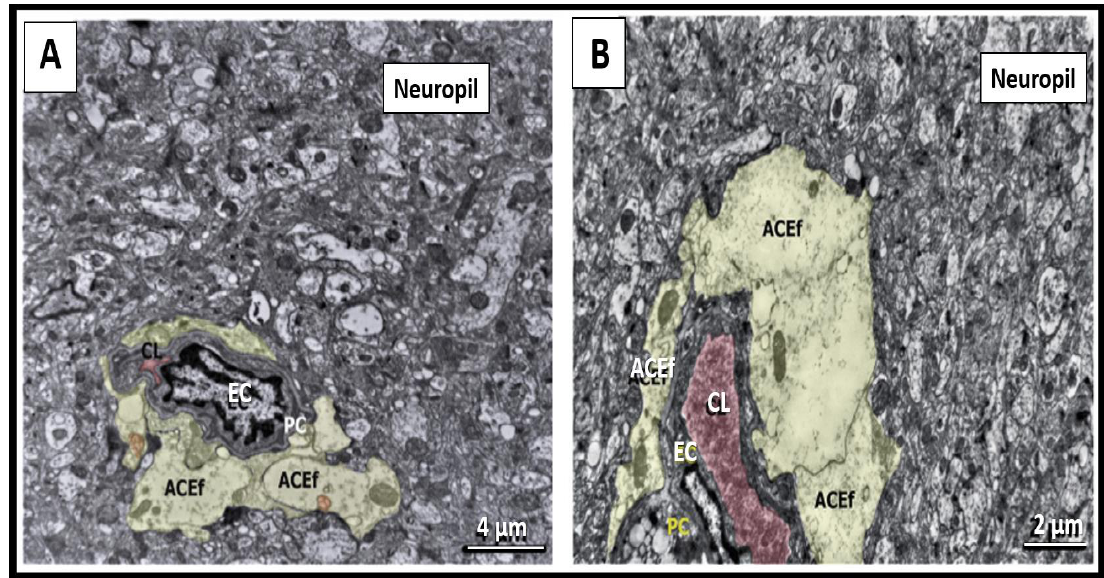
Figure 2. Ultrastructure of the cortex in acute hepatic encephalopathy. Panel ( A ) depicts the deformation and subtotal collapse of capillary lumen (pseudo-colored red) as compared to control models in Figure 1A. Note the asymmetric profound edema of astroglial capillary endfeet (pseudo-colored yellow) with several multivesicular bodies (MVBs pseudo-colored orange) from the cortex of a survived AILF-A rat 24 h after the procedure. Panel ( B ) depicts the flattened deformation of capillary lumen (pseudo-colored red) filled by condensed blood plasma. Note the asymmetric profound edema of the astroglial capillary endfeet (pseudo-colored yellow) from the cortex of a non-survived AILF-B rat 24 h after the procedure. Note that panels ( A , B ) may be compared to control model in Figure 1A. ACEf = astroglial capillary endfeet; CL = capillary lumen; EC = endothelial cell; MVBs = multivesicular bodies; PC = pericyte.